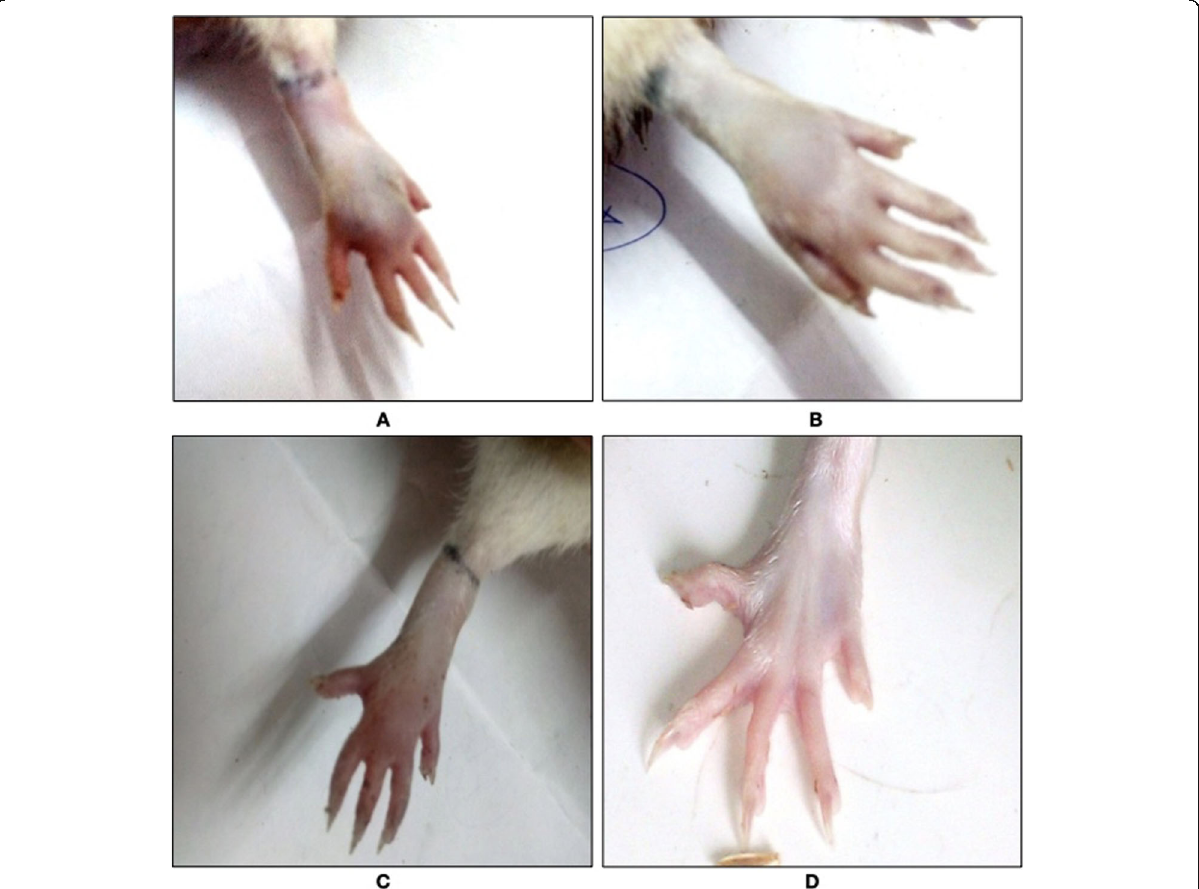
Fig. 1 Effect of Martynia annua L. extract on CPL induced paw edema in rats. a = Control group, b = Low dose group (200 mg/kg), c = High dose group (400 mg/kg), d =